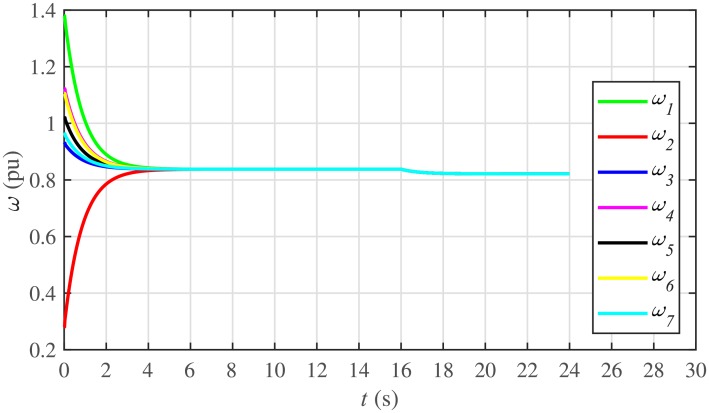
Frequency regulation under case 5. [27].